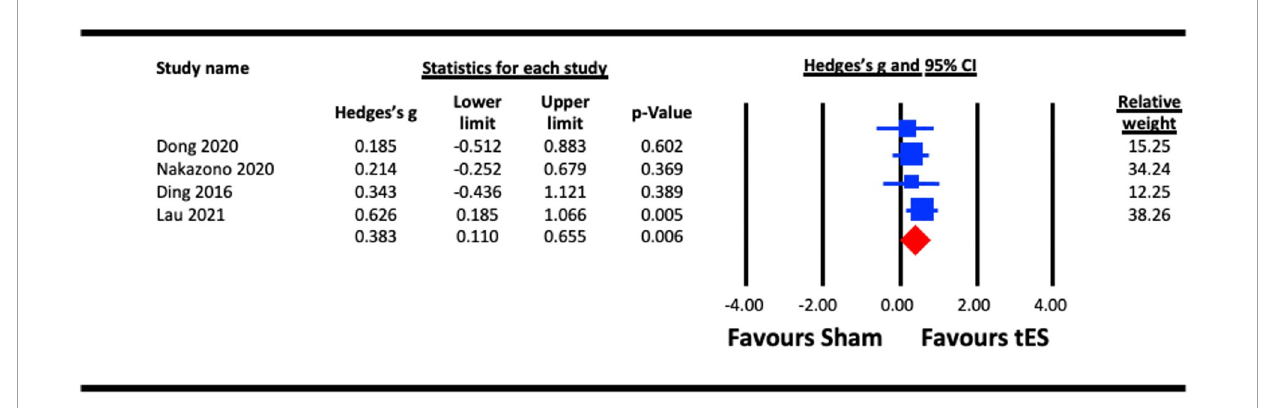
FIGURE5 Acute effect of transcranial electrical stimulation (tES) [anodal-transcranial direct current stimulation (a-tDCS) and transcranial alternating current stimulation (tACS)] on visual evoked potentials (VEPs). Nakazono (2020), combined effect of alpha and beta tACS; Lau (2021), combined effect of N1 and P1